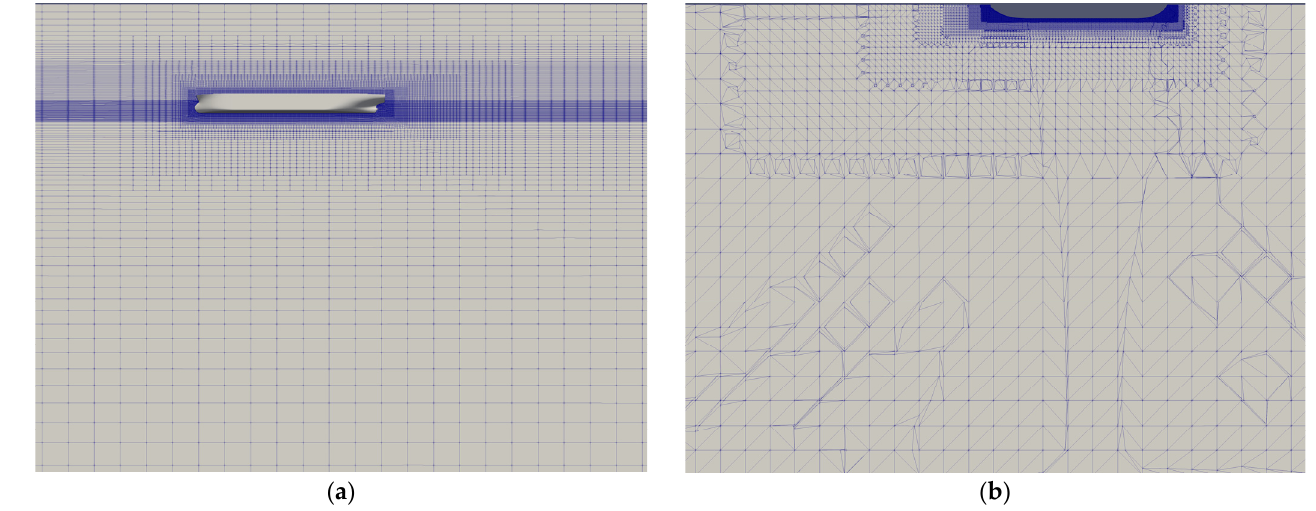
Figure 4. Volume refinement (medium grid): ( a ) Side view; ( b ) Top view. Table 1. Grid generation